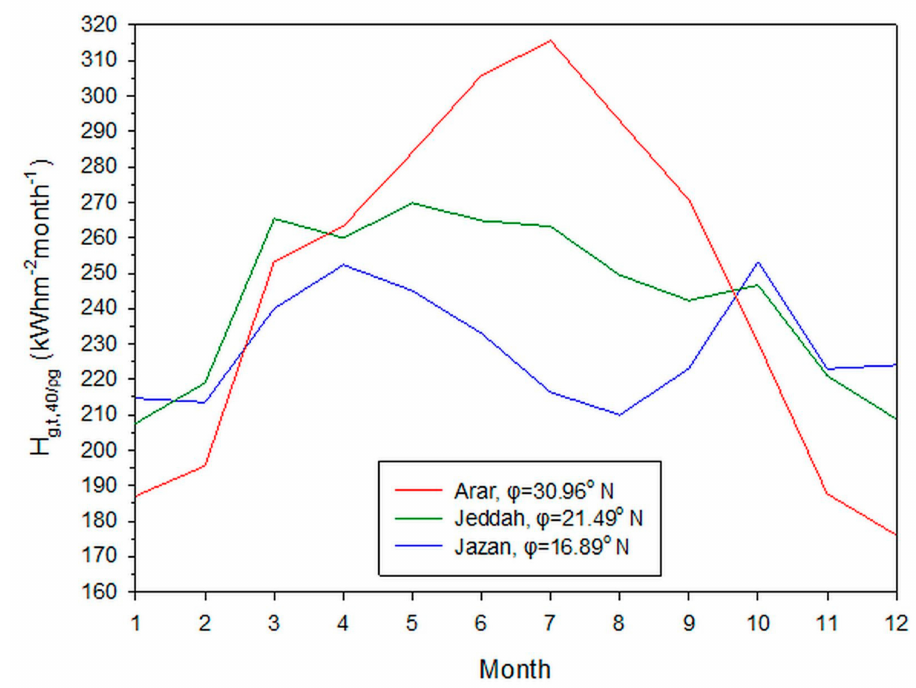
Figure 6. Intra-annual variation of the solar energy sum on a 40 ◦ -tilted plane, H g,t,40/ ρ g , at the sites of Arar (#6 in Table 1), Jeddah (#16), and Jazan (#17). The values of H g,t,40/ ρ g are averages over each month in the period 2005–2016 at 13.00 LST. The name and the geographical latitude of each site are shown in the